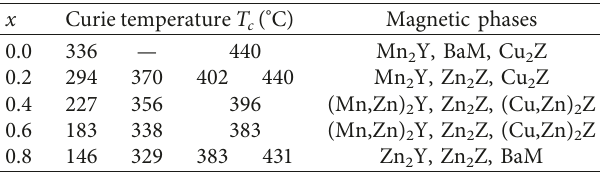
Table 6: Curie temperatures of the magnetic phases